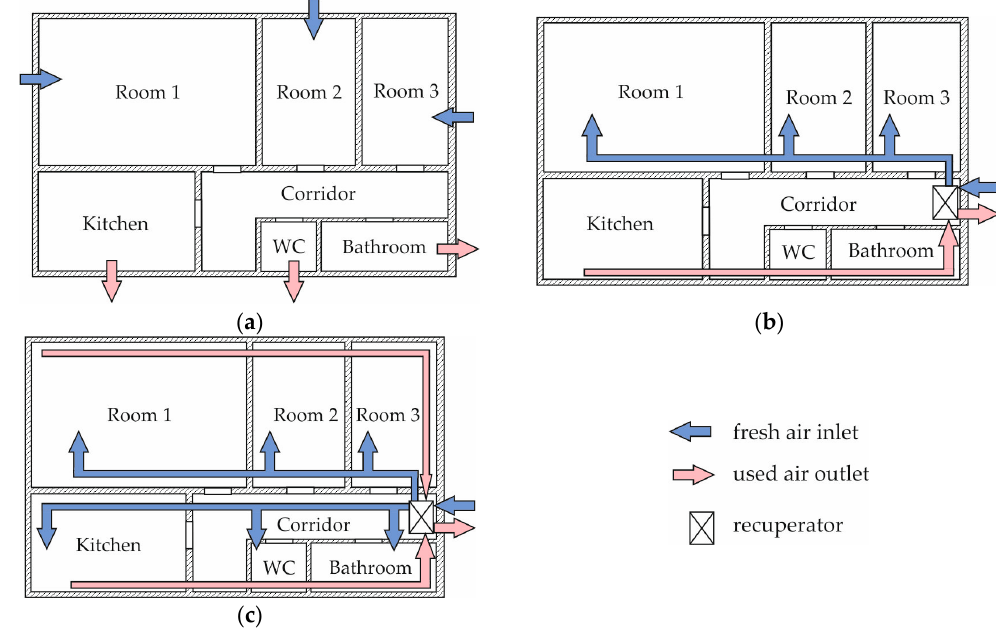
Figure 1. Example air flow distributions in the ventilation systems of residential buildings: ( a ) natural ventilation; ( b , c ) mechanical ventilation with heat recovery.